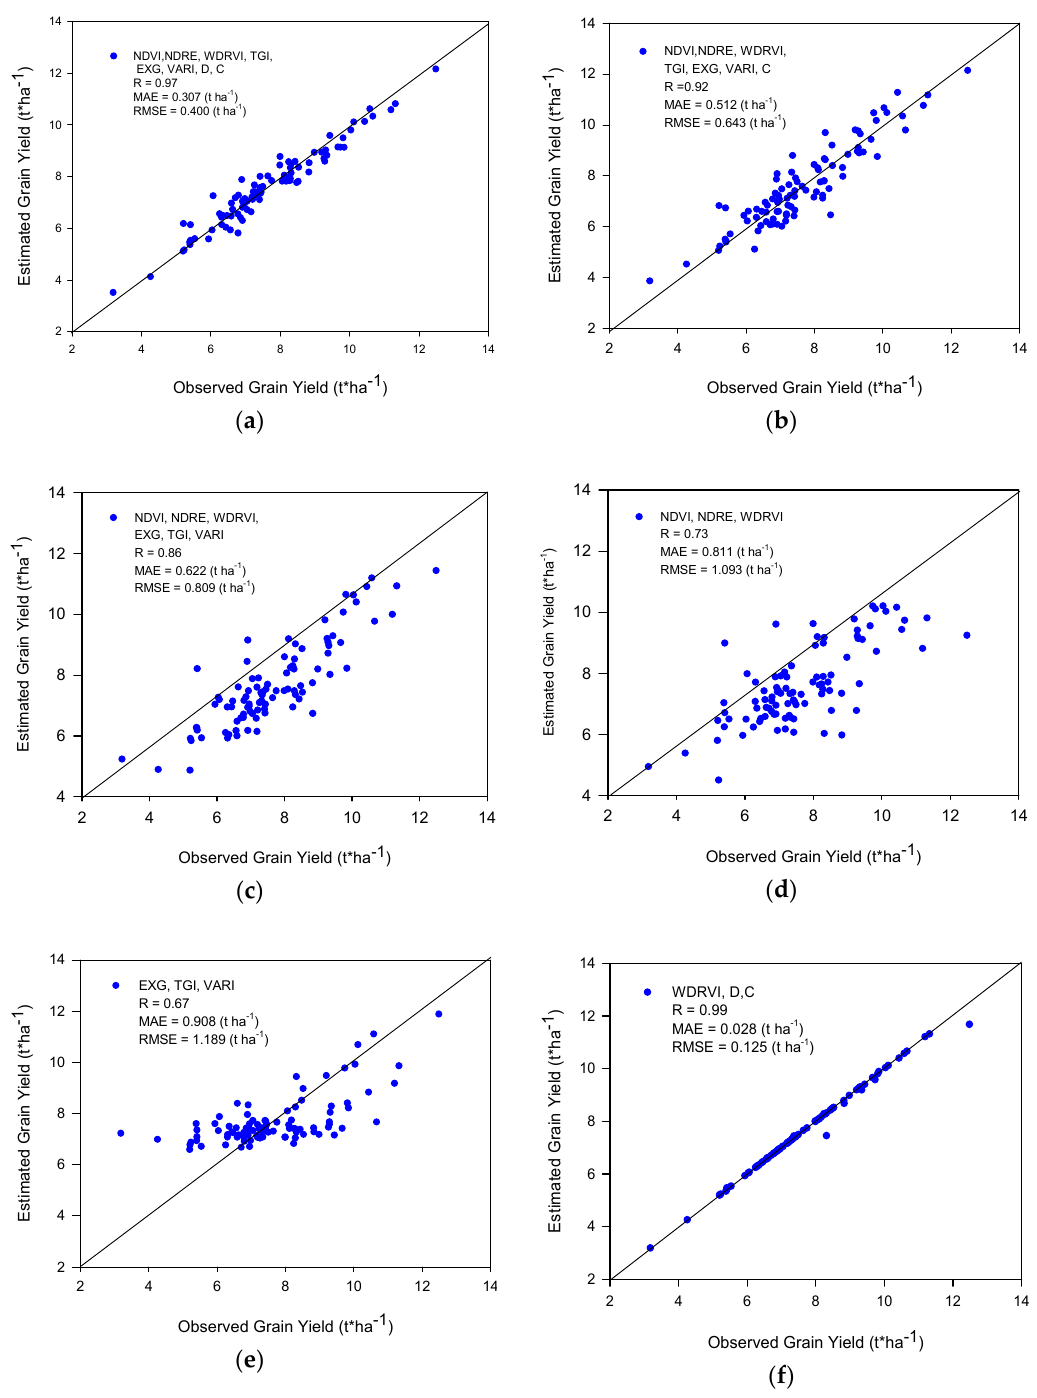
Figure 7. Yields estimated by the neural network during 47 DAS for all observed yield data. ( a ) Yield estimated with the NDVI, NDRE, WDRVI, EXG, TGI, and VARI vegetation indices, as well as planting density (D) and canopy cover (C); ( b ) yield estimated with the NDVI, NDRE, WDRVI, EXG, TGI, and VARI vegetation indices, as well as C; ( c ) yield estimated with the NDVI, NDRE, WDRVI, EXG, TGI, and VARI vegetation indices; ( d ) yield estimated with the NDVI, NDRE, and WDRVI vegetation indices; ( e ) yield estimated with EXG, TGI, and VARI vegetation indices; ( f ) yield estimated with the WDRVI vegetation index, as well as D and C.